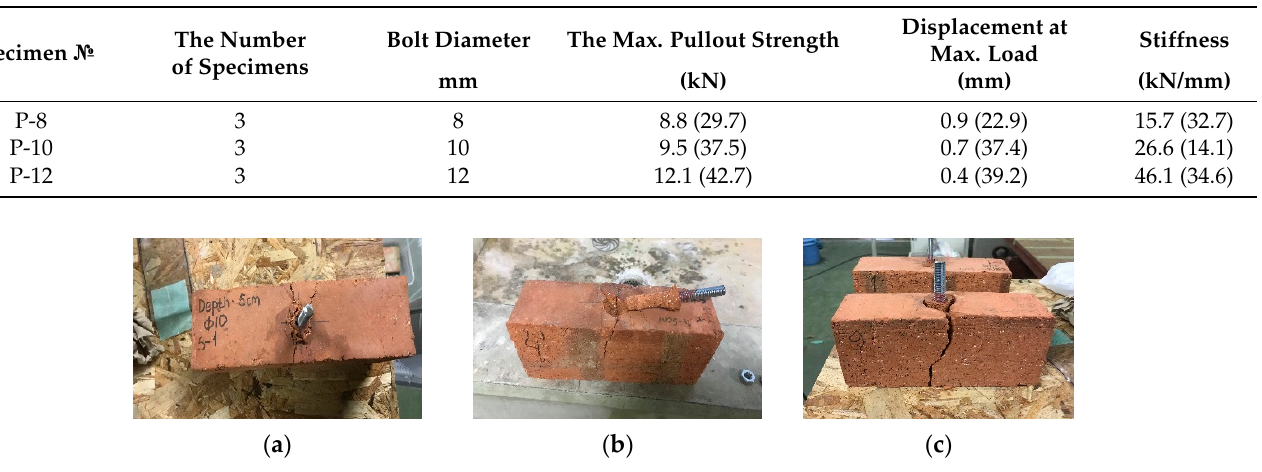
Table 7. The result of the pullout experiment.